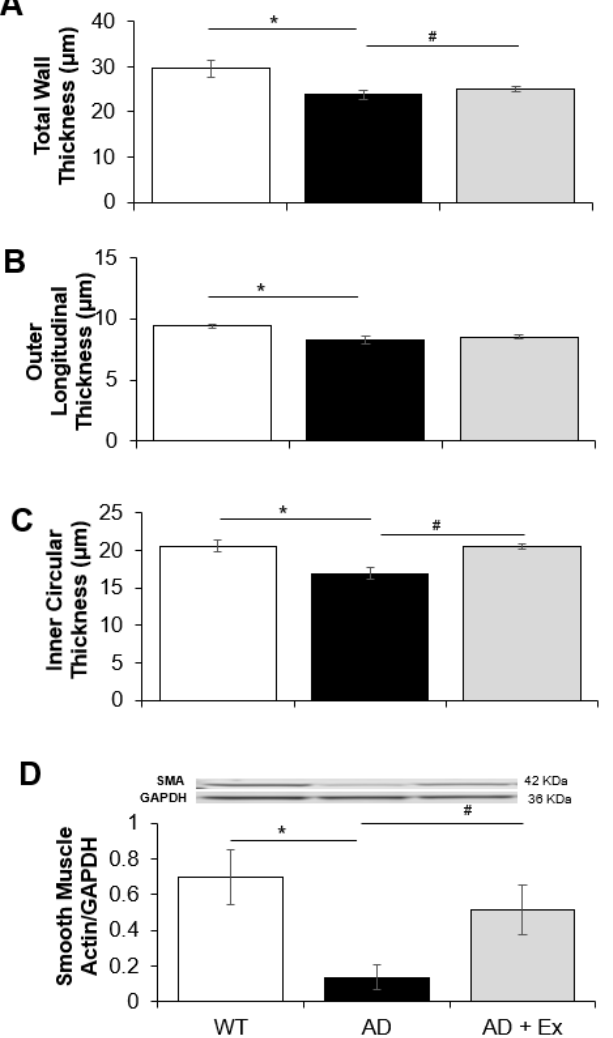
Figure 3. The effects of exercise training on wall dimensions and smooth muscle actin expression in 3xTg-AD mouse jejunum. Total wall thickness ( A ), outer longitudinal wall thickness ( B ), inner circular wall thickness ( C ) and total protein expression of smooth muscle actin expression ( D ) of jejunum from 3xTg-AD mice. Wall thicknesses are expressed in μM. Protein expression of smooth muscle actin was normalized using GAPDH. Values are reported as mean ± SEM for 7–9 mice per group for the wall dimensions and 5–8 mice per group for smooth muscle actin. * indicates significance compared to WT control mice, p < 0.05; # indicates significance compared to 3xTg-AD mice, p < 0.05. AD, Alzheimer’s disease; WT, wild type; Ex, exercise.